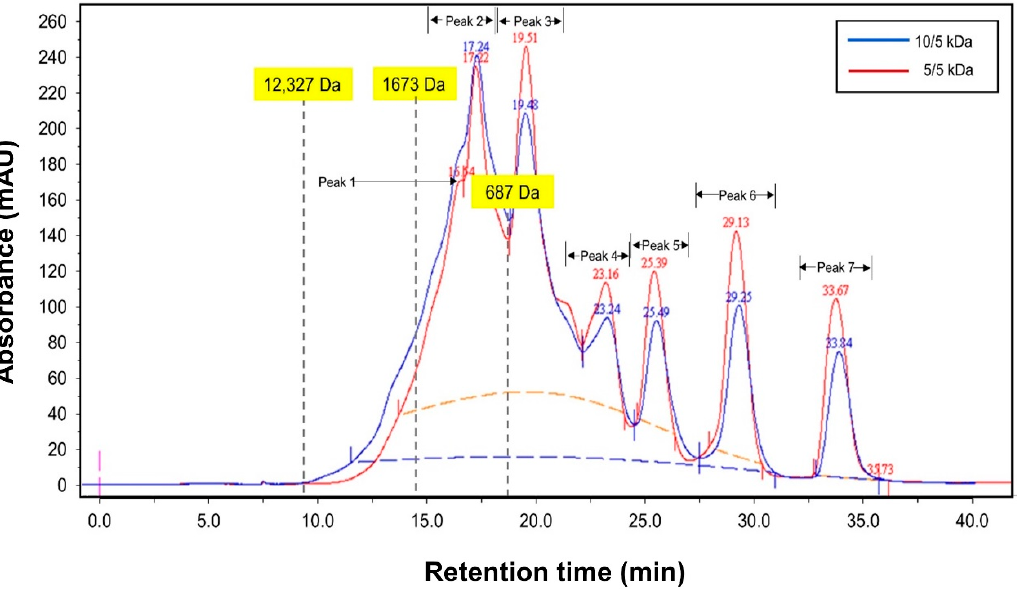
Figure 8. FPLC (Fast Pressure Liquid Chromatography) chromatogram profiles of TB protein hydrolysate that fractionated using ultrafiltration membranes of 10/5 and 5/5 kDa at 3 bar, 300 rpm, and pH8.